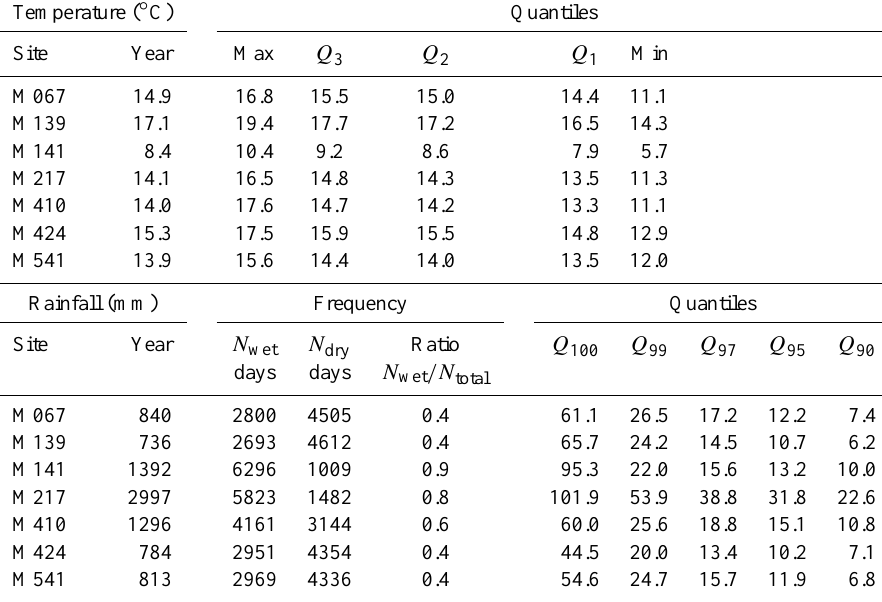
Table 2. Observed mean annual temperature and rainfall, quantiles of monthly temperature, quantiles of daily rainfall depths, and number of wet/dry days at the observed sites during the control period